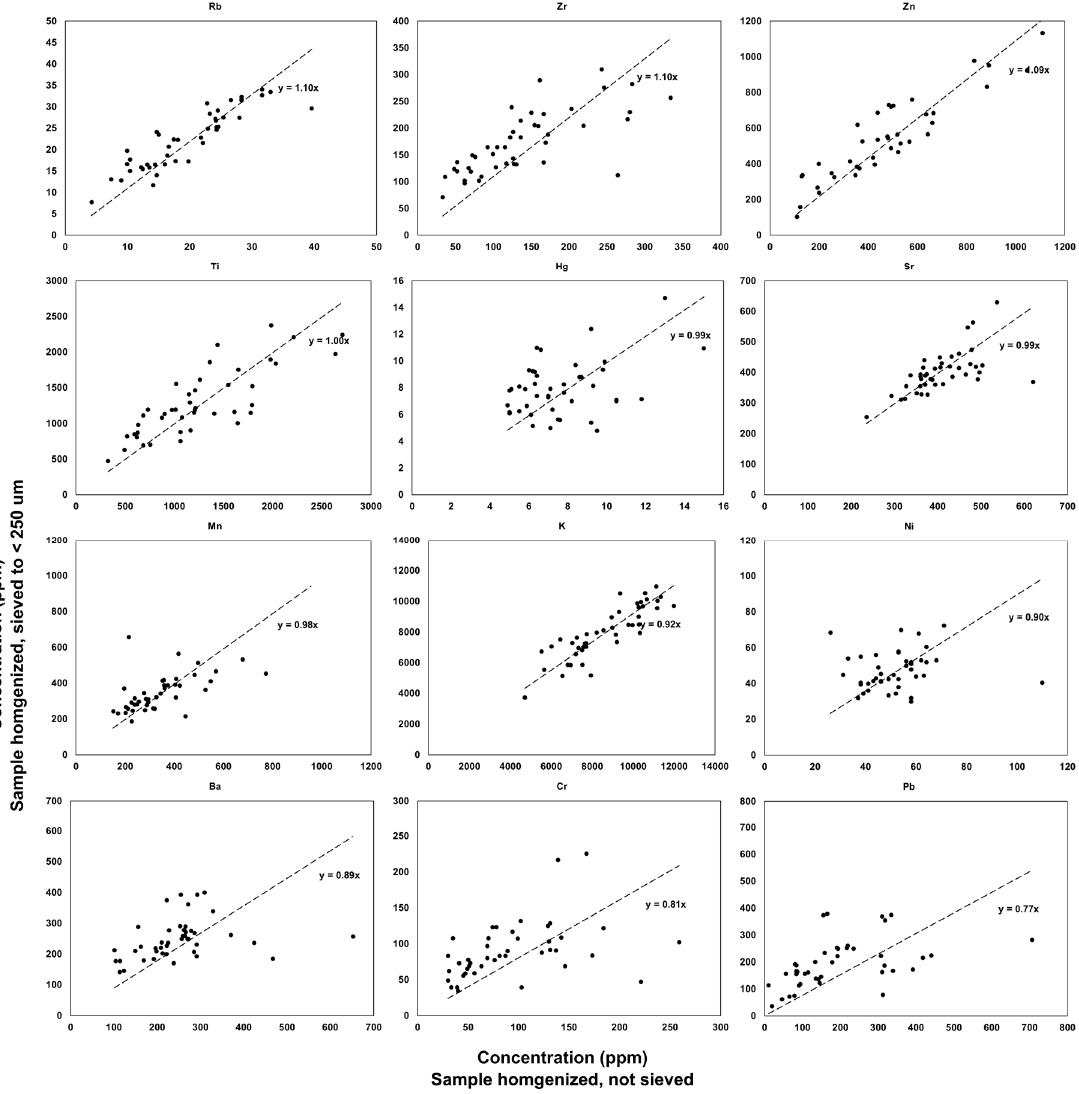
Figure 2. Regressions of portable XRF measurements on samples sieved to <250 µm against measurements on samples homogenized only. Dashed black line represents linear trend. Elements sorted by slope in descendent